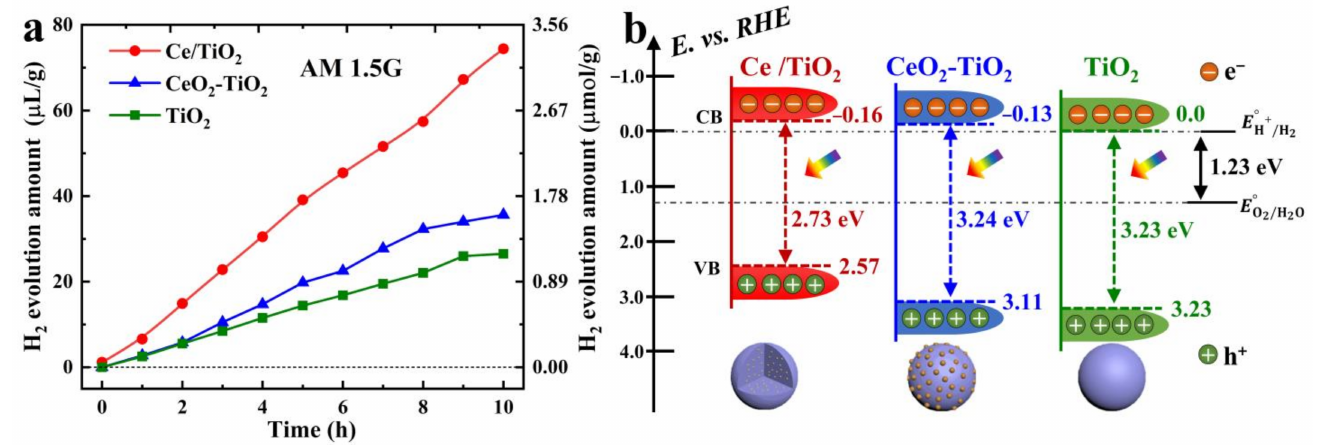
Figure 9. ( a ) Photocatalytic hydrogen evolution of the pure TiO 2 , CeO 2 -TiO 2 , and Ce/TiO 2 ; ( b ) proposed band structures of the pure TiO 2 , CeO 2 -TiO 2 , and Ce/TiO 2